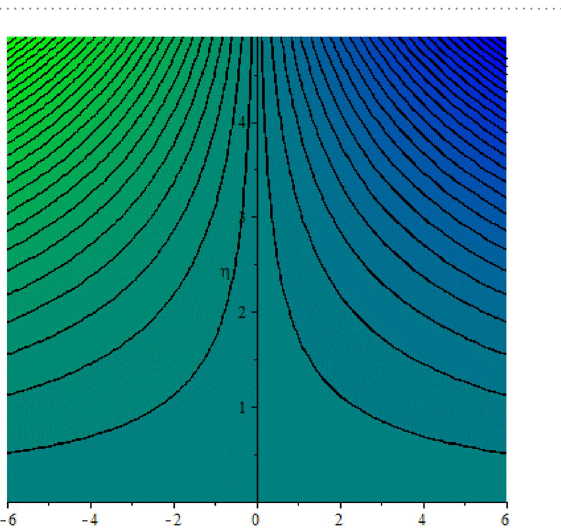
Figure 15. Stream lines when γ = 0.0 and β → ∞ .